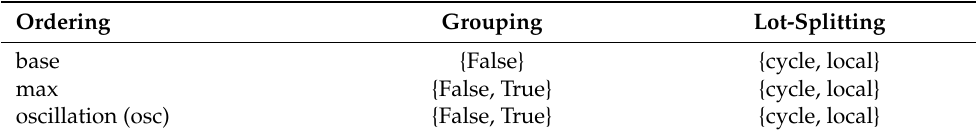
Table 2. Rules defining the sequencing and lot-sizing of daily orders.